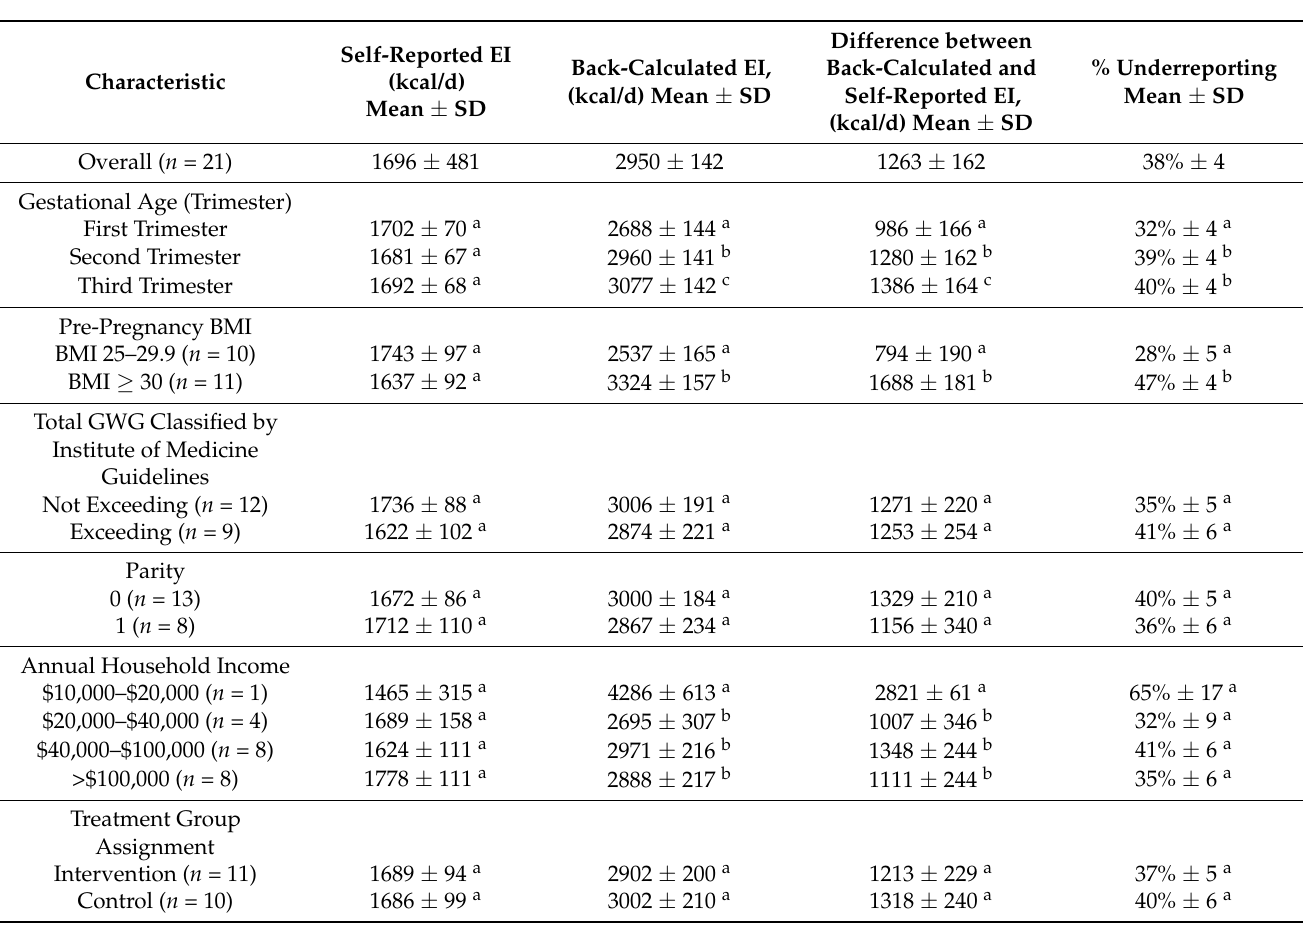
Table 2. Energy Intake (kcal/d) and Underreporting During Pregnancy by Maternal Characteristics and Treatment Group in Pregnant Women with Overweight and